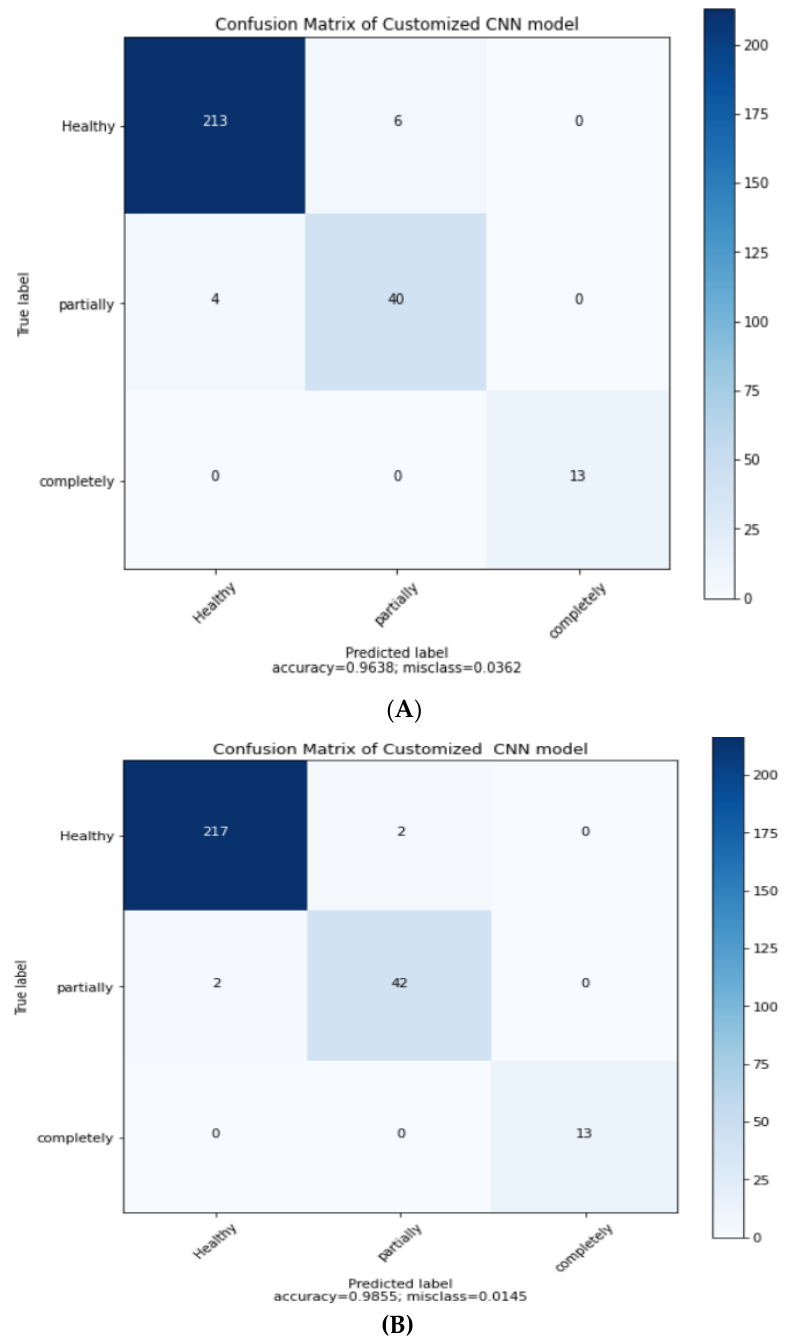
Figure 6. Confusion matrices. ( A ) The confusion matrix of the standard CNN model with Adam